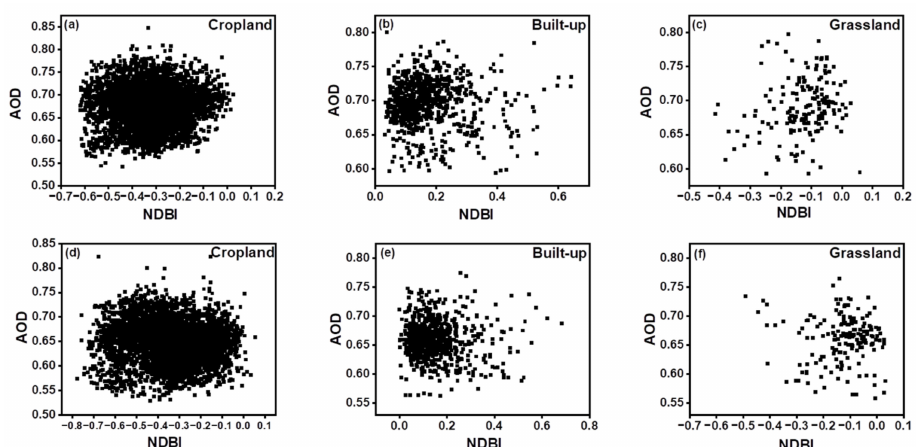
Figure 10. Scatterplot depicting the relationship between NDBI and AOD (Aqua ( a – c ), & Terra ( d – f )) values for different LULC classes.